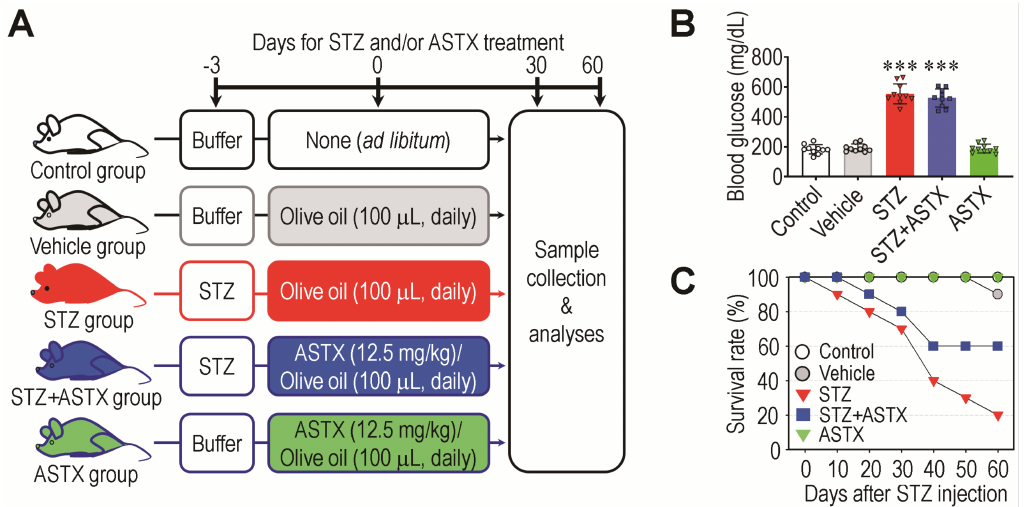
Figure 1. Long-term oral gavage of ASTX ameliorates hyperglycemia-induced lethality, but not blood glucose level, in STZ-injected mice. ( A ) A schematic illustration of the experimental design. ( B ) Blood glucose level of mouse groups at 60 days post-hyperglycemia induction ( n = 7/group). ( C ) Survival rate (%) of mouse groups at the indicated days after STZ injection ( n = 10/group). *** p < 0.001 by unpaired Student’s t